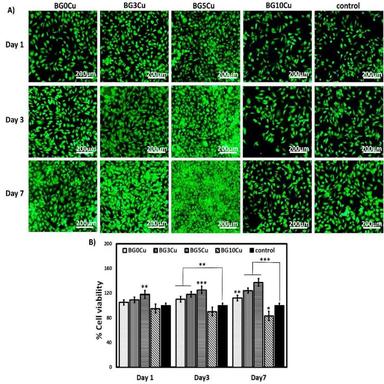
(A) Fluorescence microscopy images of human umbilical vein endothelial cellsproliferation and morphology after 1, 3, and 7 days of incubation with different extracts of the modified bioactive glasses (BGs) and the control group indicate that Cu incorporation into the modified BGs structure stimulates cell proliferation. (B) The MTT assay determined the viability of endothelial cellsafter 1, 3, and 7 days of incubation with various extracts of the modified BGs and the control graft, revealing that the modifi